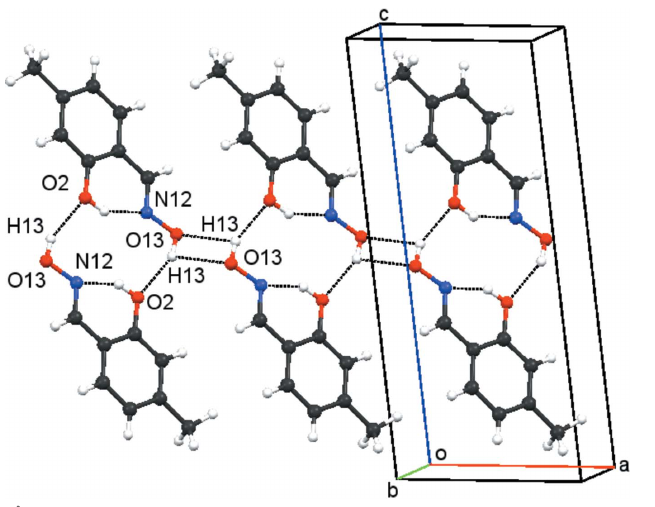
Figure 4 Part of a two-molecule-wide chain in 1 (symmetry codes as in Table 1).